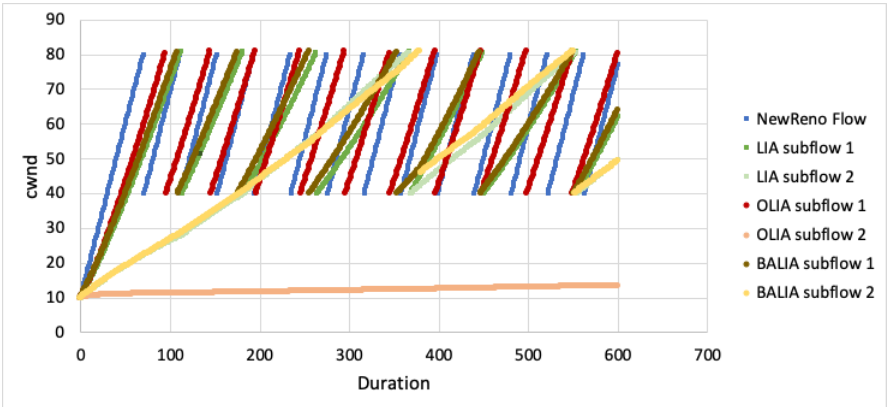
Figure 7. Window growth- Subflow 1 RTT = x , Subflow 2 RTT = 2 x .